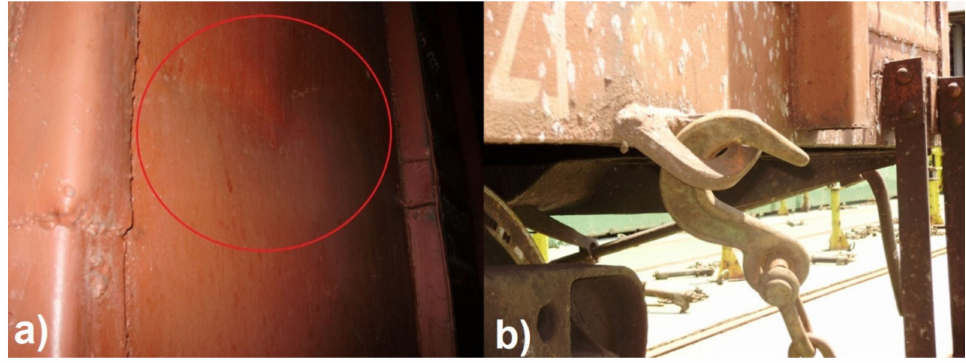
Figure 4. Damage to the elements of the bearing structure of a rail car ( a ) deformation of the top cord; ( b ) deformation of the tow brace.